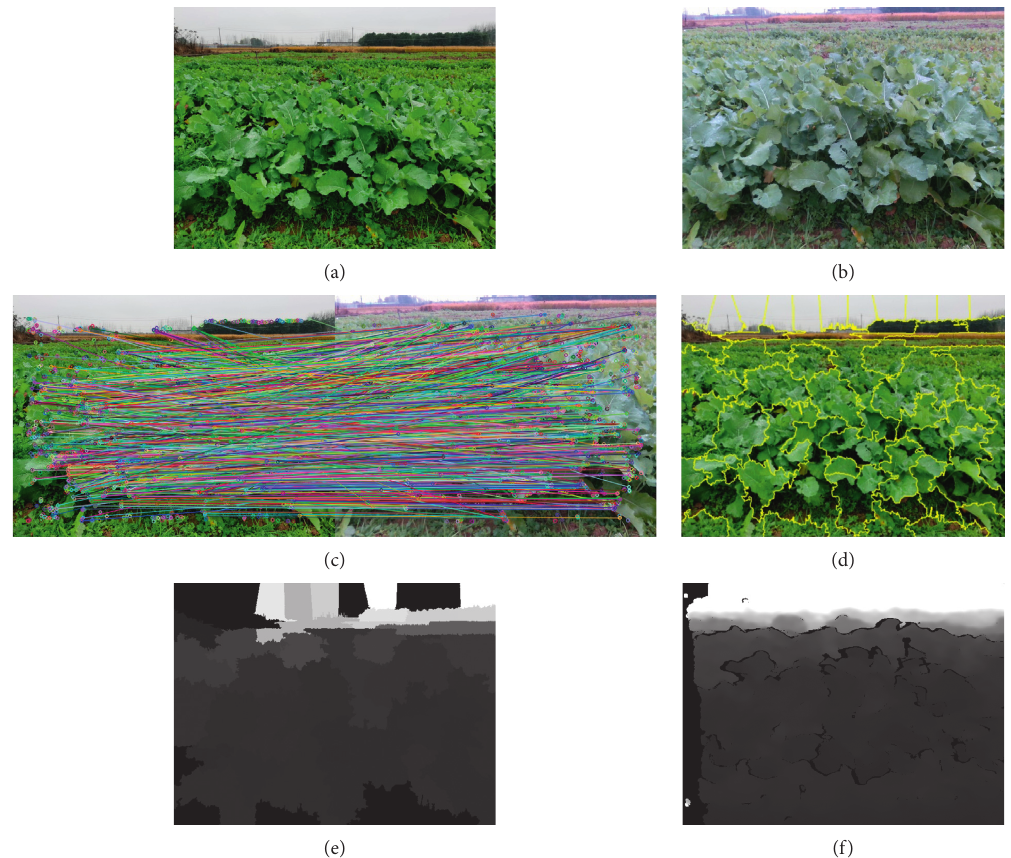
Figure 7: Algorithm test results. (a) The RGB image captured by mobile phone. (b) The RGB image captured by RealSense D435. (c) The feature point matching result. (d) Superpixel segmentation results. (e) The depth map generated by the algorithm in this paper. (f) Depth map taken by depth